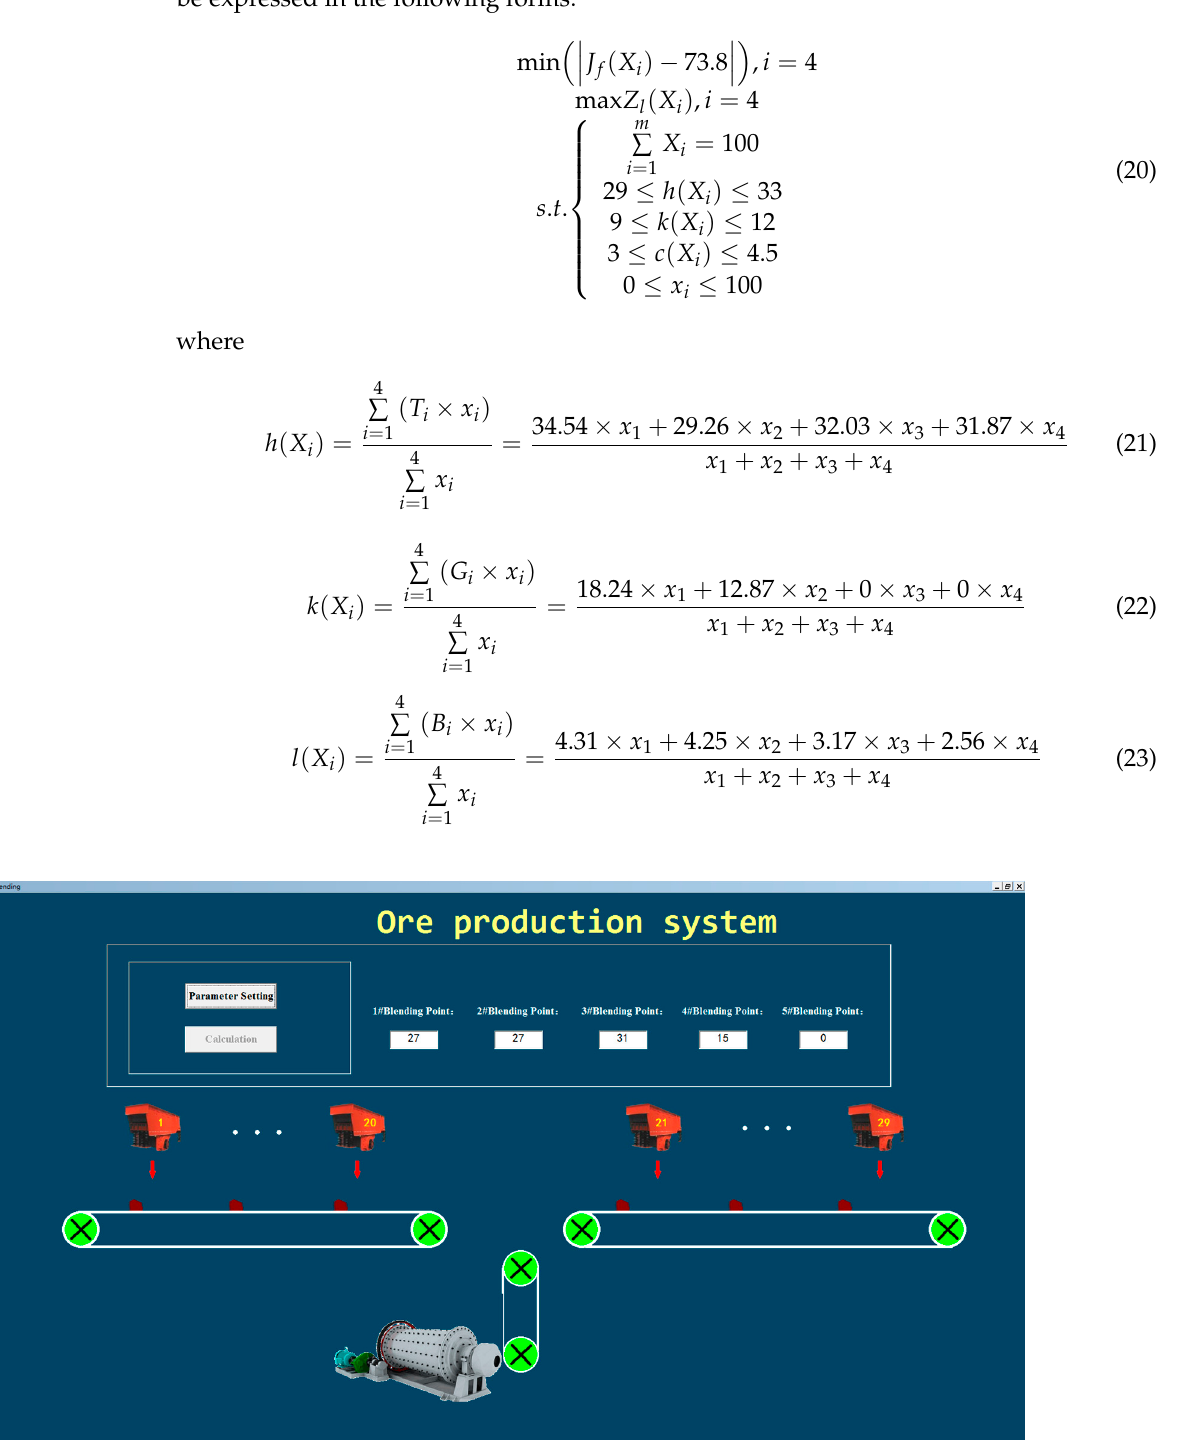
Figure 4. Main interface of the ore blending system.